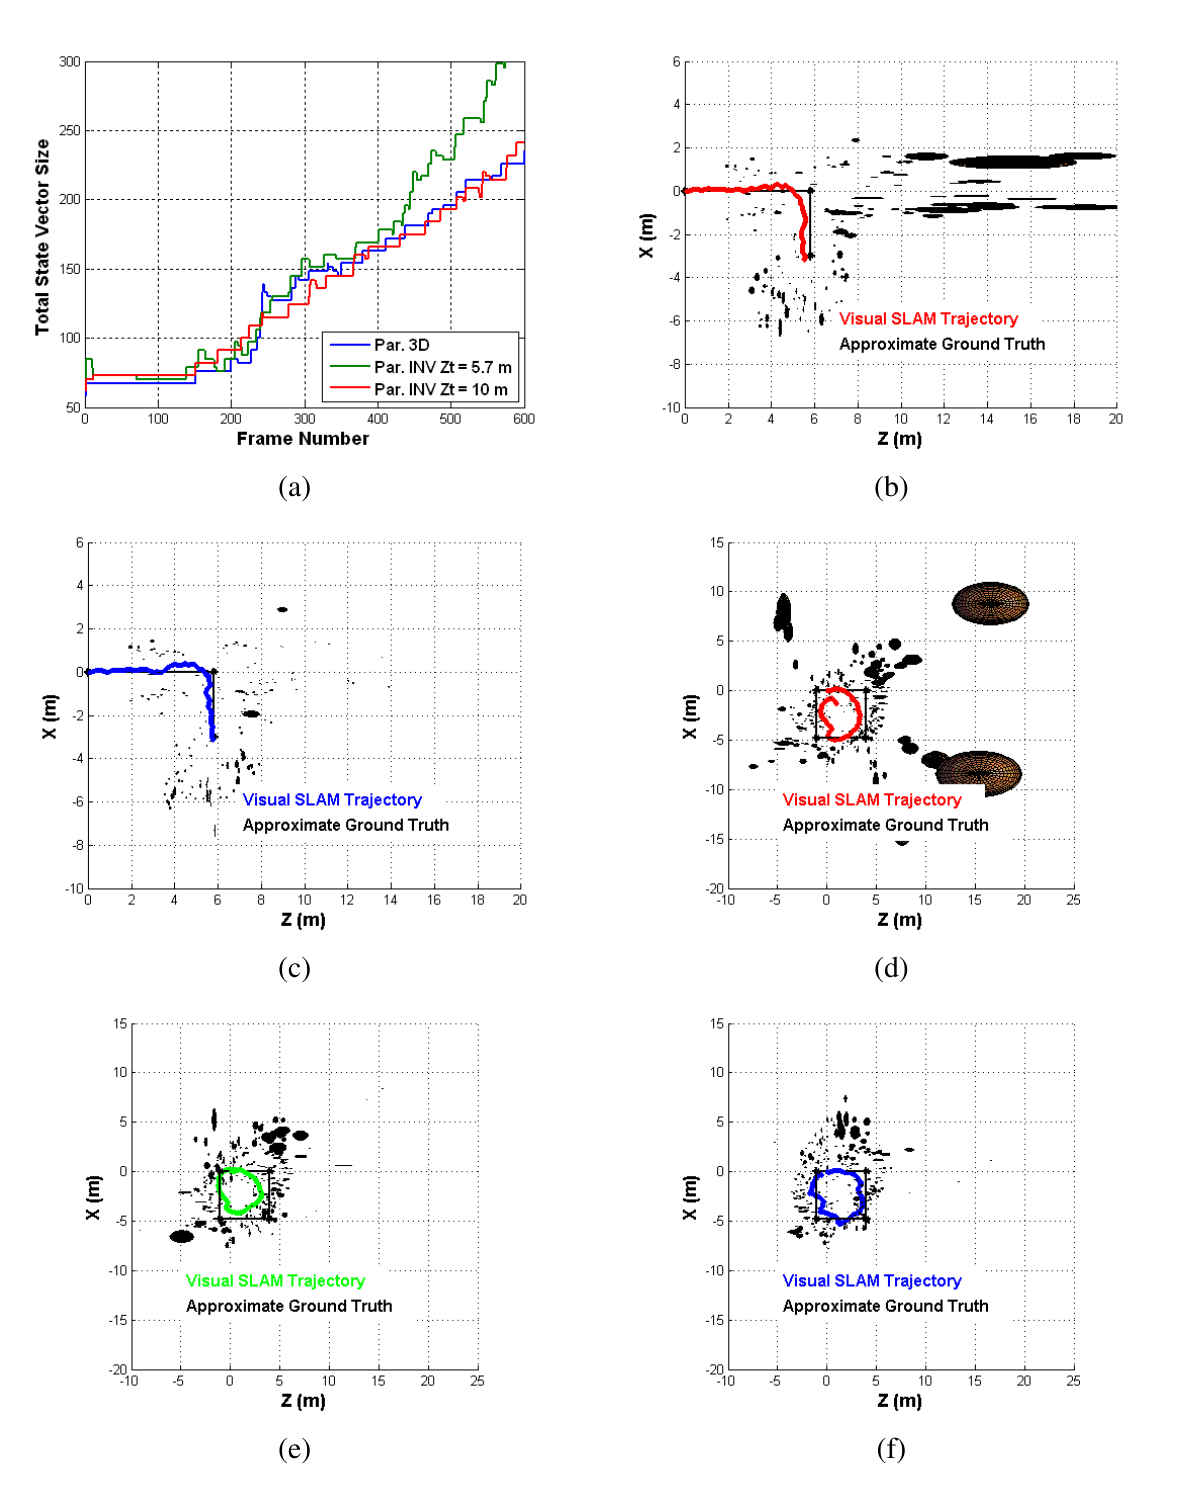
Figure 6. Inverse depth and 3D comparison. (a) Total state vector size, (b) Without inverse depth par. L sequence, (c) with inverse depth par. Z = 5.7 m L sequence, (d) without inverse depth par. loop sequence, (e) with inverse depth par. Z = 10 m loop sequence, (f) with inverse depth par. Z = 5.7 m loop